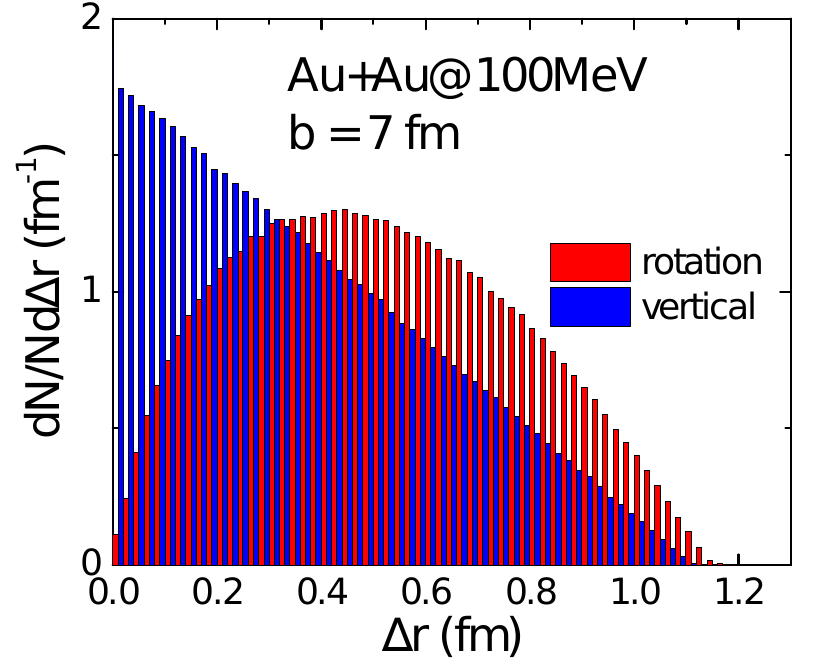
Figure 4. Comparison of the histograms for the side-jump distance of particles in the computational frame from two collision prescriptions in non-central Au+Au collisions at E lab = 100 AMeV. The distributions are normalized to